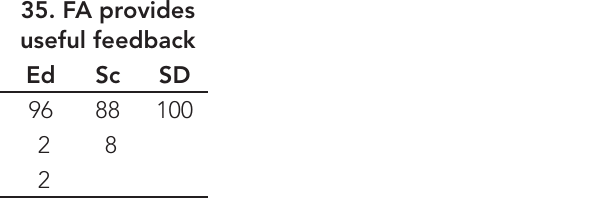
Table 13: Summative and formative assessment provide useful feedback